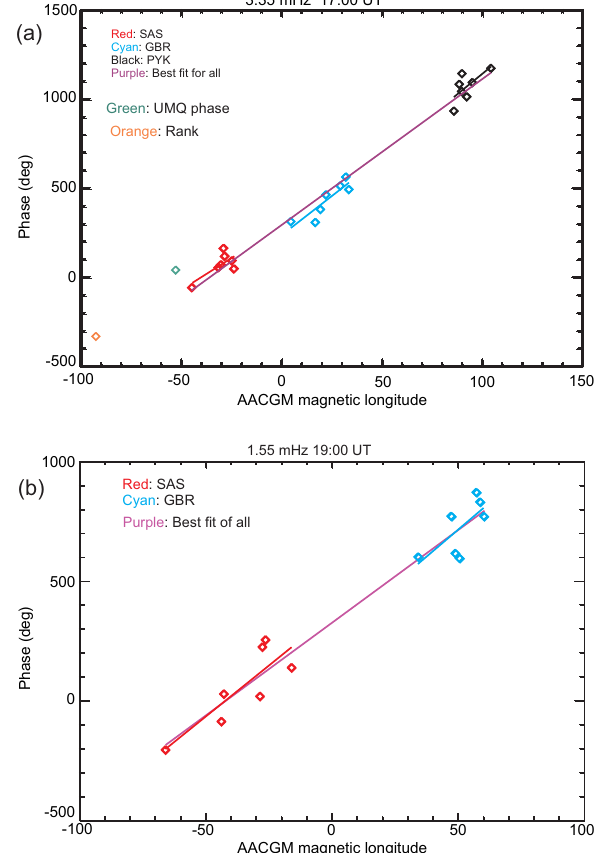
Figure 11. Event 2: (a) plot of phase versus longitude measured at 17:00UT for the 3.35mHz frequency. The slope of this relation yields the azimuthal wave number m : 7 ± 3 . 2 for Saskatoon (red), 9 ± 2 . 3 for Goose Bay (cyan) and 9 ± 4 . 3 for Þykkvibær (black), corresponding to a westward phase velocities at the ionosphere. The m value of the three radars is ∼ 8 ± 0 . 3 (purple). The phase of the resonance from the magnetometers RANK and UMQ were deter- mined and plotted (green: UMQ; orange: RANK). (b) Event 3: plot of phase versus longitude measured at 19:00UT for the 1.55mHz frequency for event 3. The slope of this relation yields the azimuthal wave number m : 9 ± 2 . 4 for Saskatoon (red) and 9 ± 4 . 3 for Goose Bay (cyan), corresponding to a westward phase velocity at the iono- sphere. The m value of the two radars is ∼ 8 ± 0 . 5